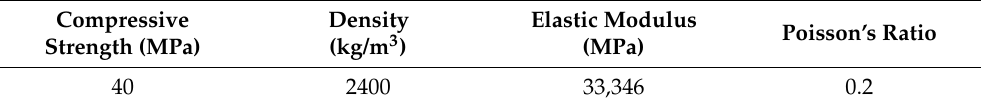
Table 6. Material properties of concrete.